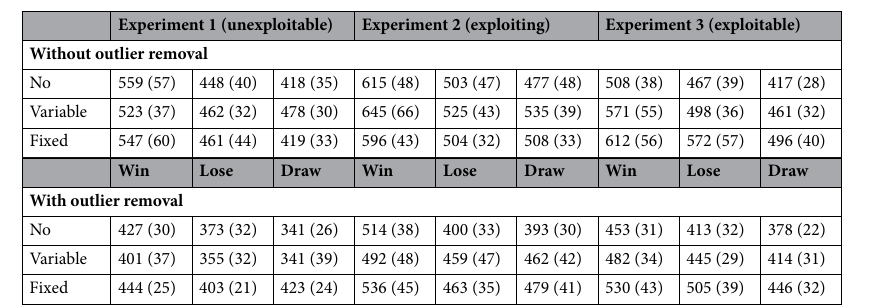
Table 3. Reaction times for the three outcomes (win, lose, draw) as a function of credit (no, variable, fixed) across Experiments 1–3. Standard error in parenthesis.